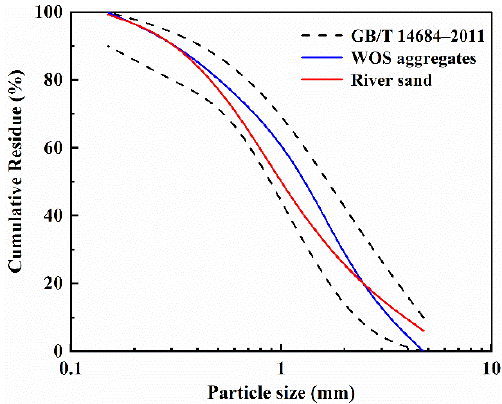
Figure 1. Gradation curves of WOS aggregates and river sand.